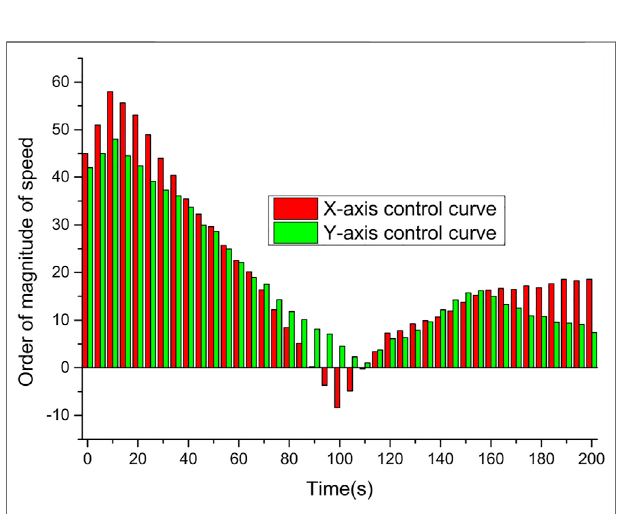
FIGURE 8 | Following target tracking